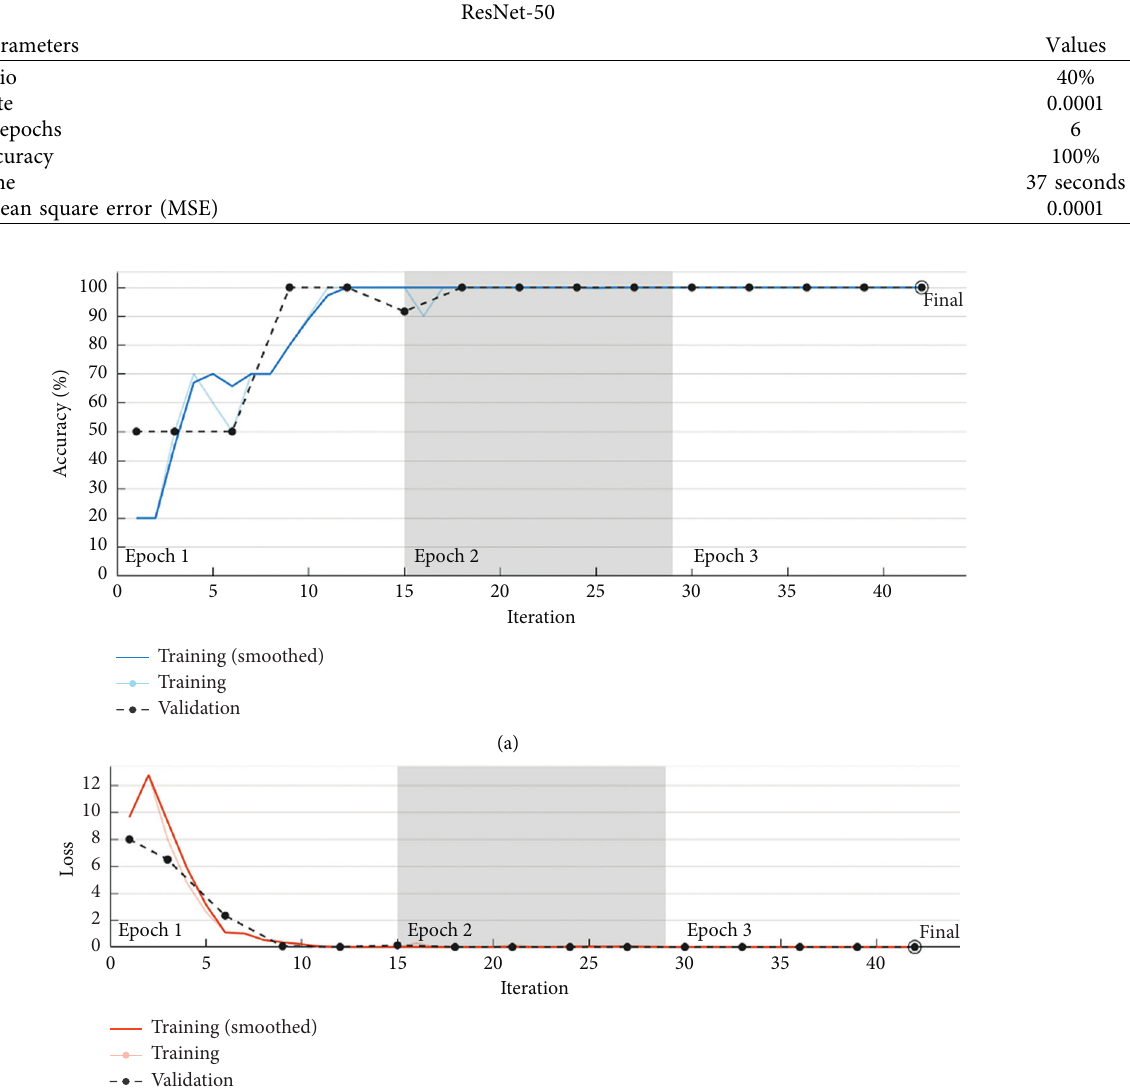
Table 1: Models learning parameters.